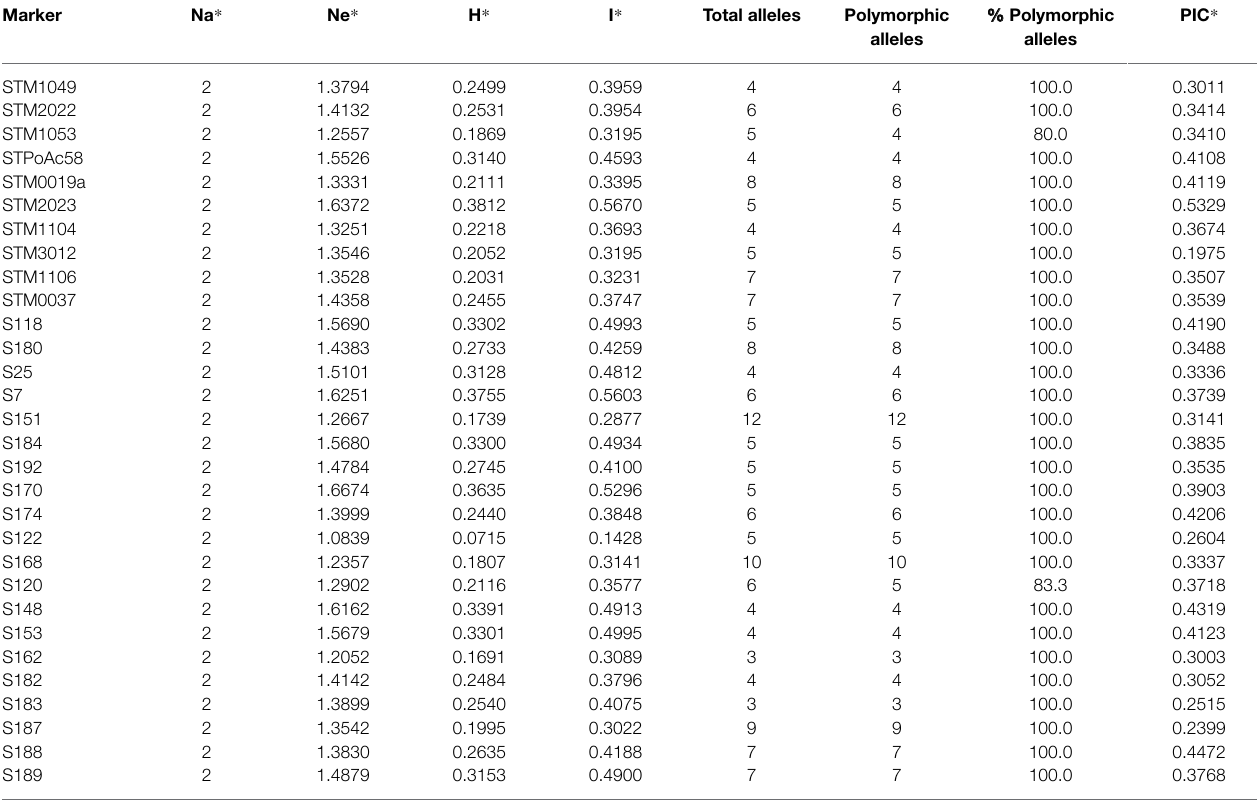
TABLE 3 | Genetic diversity parameters of 30 SSR markers evaluated in 189 potato genotypes. Marker Na * Ne